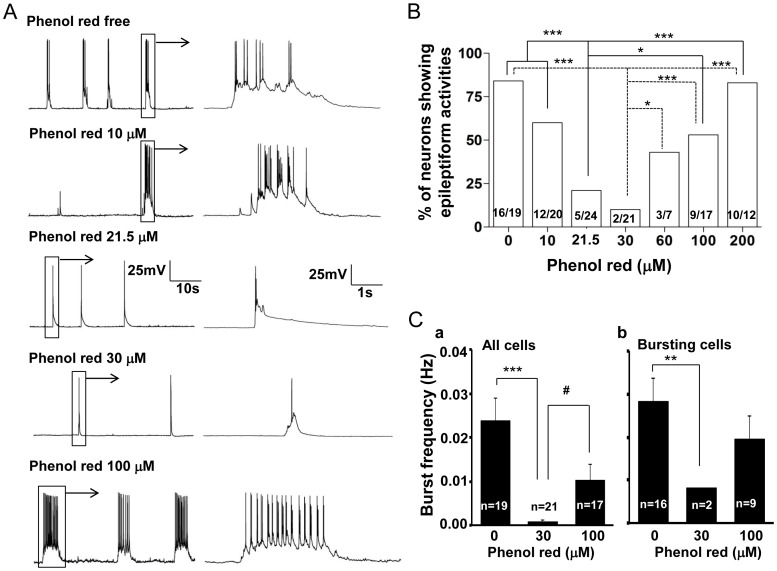
U-shape inhibition of the bursting activities in cultured hippocampal pyramidal neurons by phenol red.A. Current clamp traces showing hippocampal pyramidal neurons with different firing patterns in culture media with different phenol red concentrations (0, 10, 21.5, 30, 100 µM). Low and high concentrations of phenol red induced the most prominent and longer lasting depolarizations and bursting activity. B. Group data showing the U-shape suppressive effect of phenol red on the percentage of the bursting neurons in different concentrations of the phenol red (0–200 µM). C. Group data analysis showing the most significant decrease of the burst frequency by phenol red at 30 µM pooled either in all tested neurons (P<0.001) (a) or in only the bursting neurons (P<0.01) (b). **P<0.01, ***P<0.001; #P<0.05.